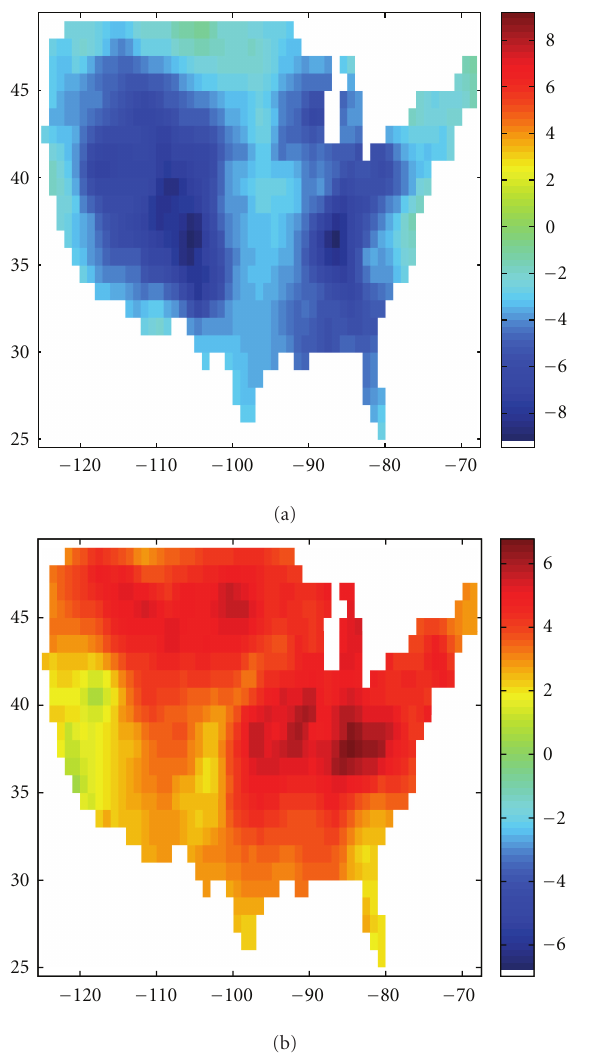
Figure 6: Gridded annual minimum temperature (K), relative to the 1976–2005 mean, over the coterminous USA, for individual cold and warm winters: (a) 1962-1963, (b) 2011-2012.